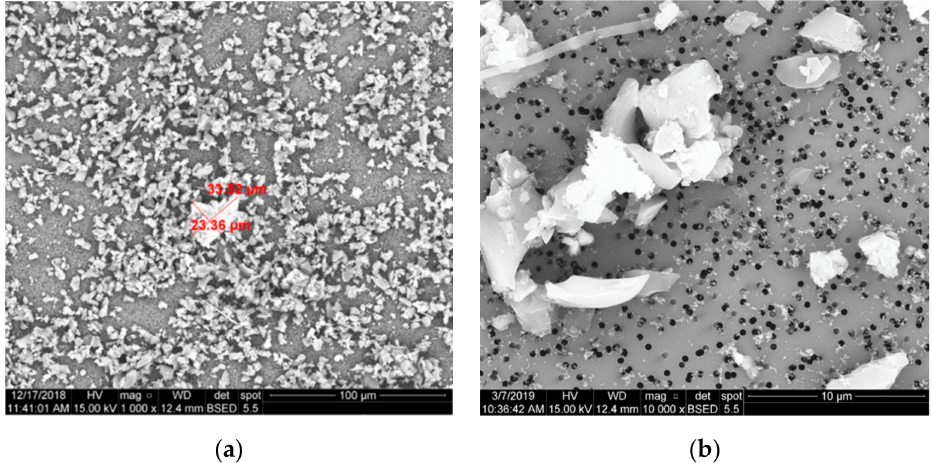
Figure 5. Photographs of dust particles collected showing ( a ) an oversized (>10 micron) particle and ( b ) clear presence of very fine diesel